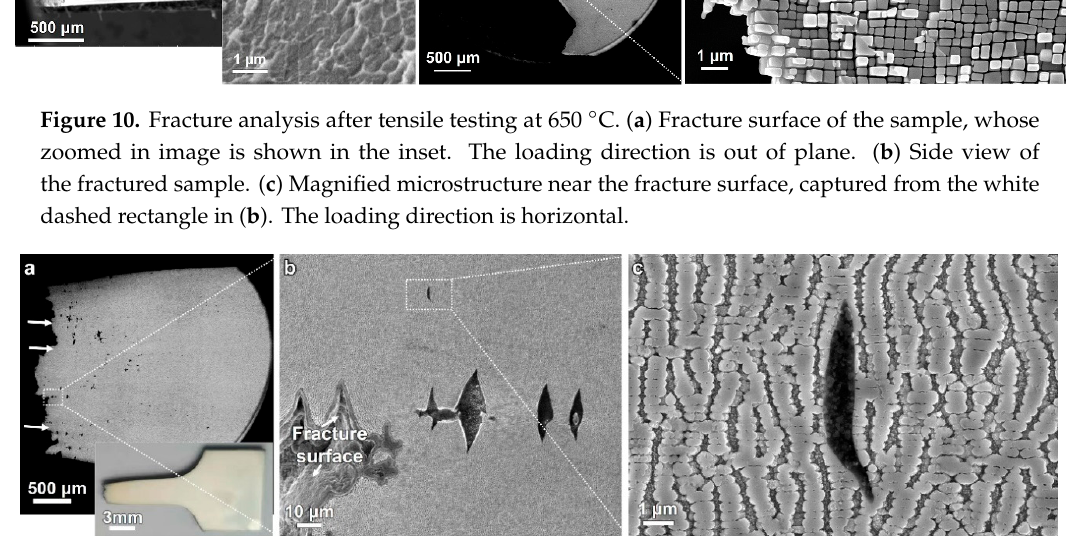
Figure 11. Fracture analysis after the tensile test at 1100 °C. ( a ) Side view of fractured sample (Backscattered electron image). The inset is an optical photograph of the necked sample. ( b ) Micro- cracks in the interdendritic region near fracture surface, captured from the area marked out by white dashed rectangle in ( a ). ( c ) Magnified microstructure near the fracture surface, obtained from the white rectangle in ( b ). The loading direction is horizontal in all images.